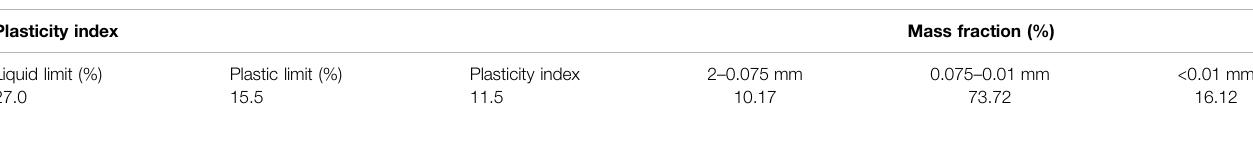
TABLE 1 | Basic physical parameters of the original loess. Plasticity index Mass fraction